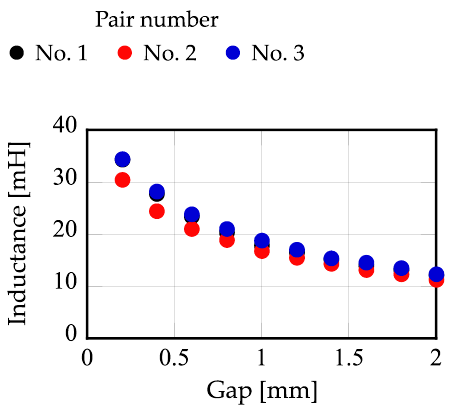
Figure 15. Estimated mutual inductance of electromagnet at various gaps.